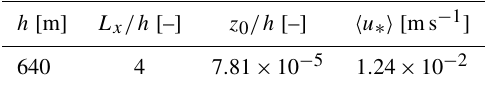
Table 5. Parameters used for simulation of square duct flow in